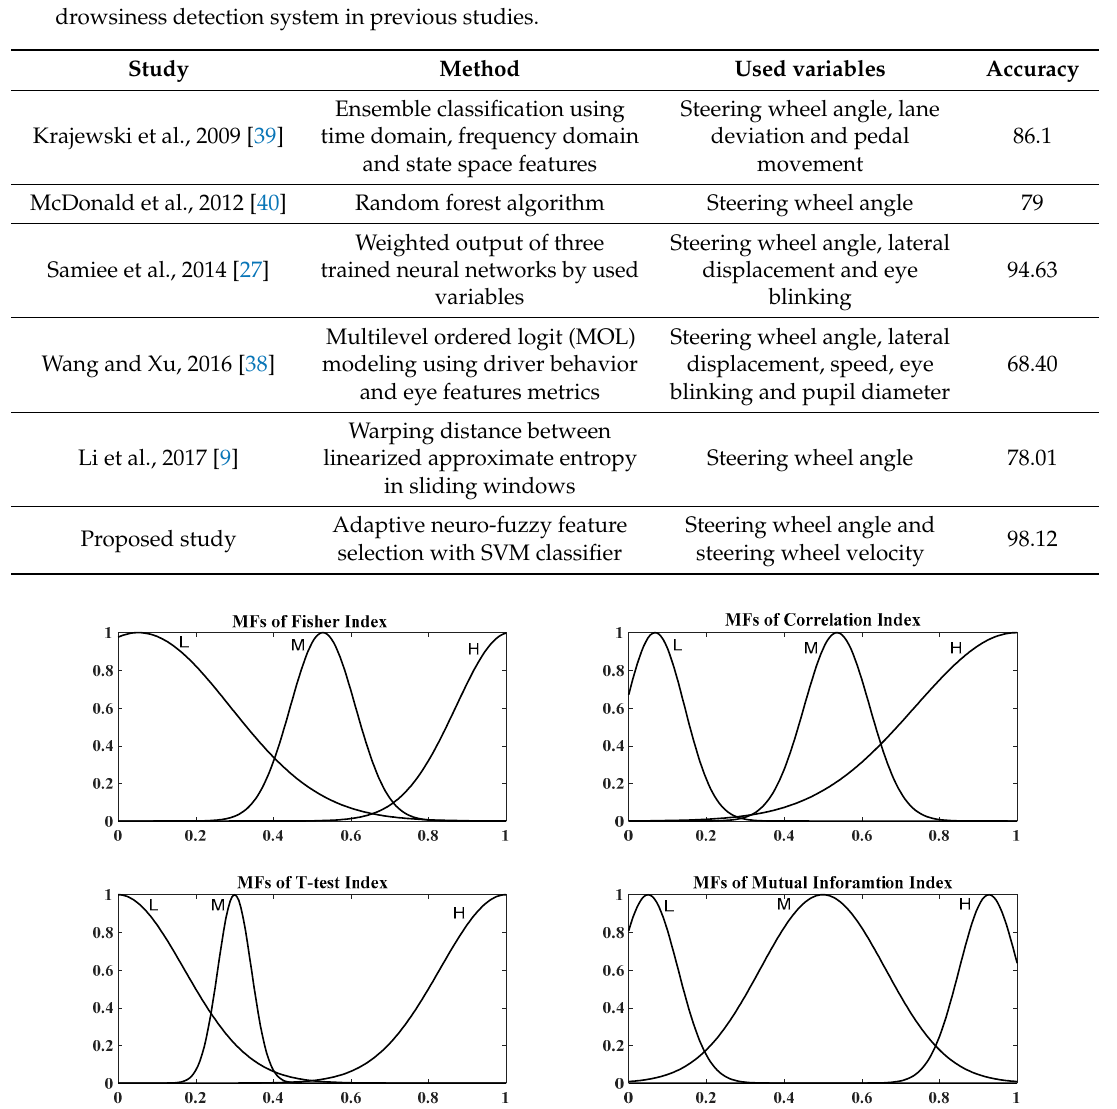
Figure 7. Final membership functions; upper left: Fisher index, upper right: Correlation index, lower left: T-test index, and lower right: Mutual information index.